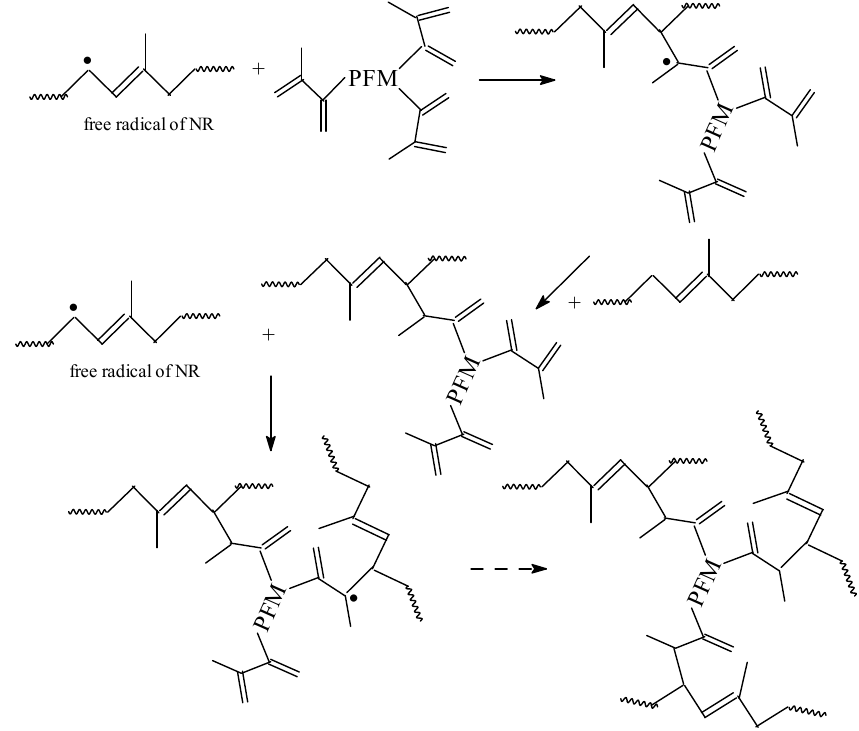
Figure 4. Possible mechanism of NR cross-linking and grafting in the presence of TMPT by EB irradiation.